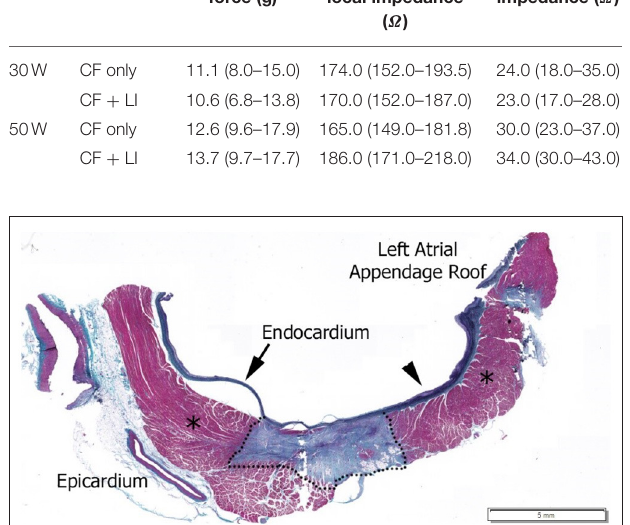
FIGURE 2 | Hematoxylin and Eosin stained histological image of a 30W, 9s RF application with a 22 Ω drop in local impedance on the left atrium posterior wall. Dashed line outlines mature lesion, *Regions are normal myocardium as identified by pathologist.